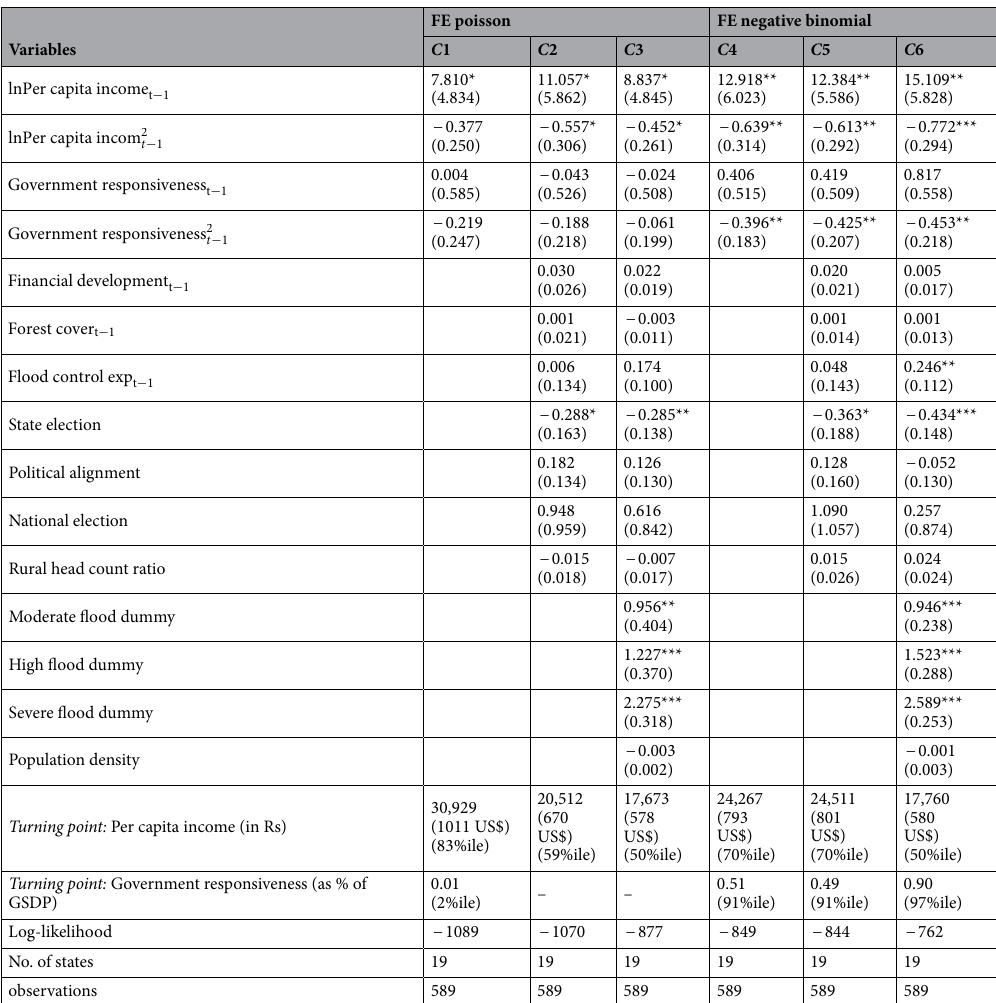
Table 2. Population affected, per capita income (PCI) and Government responsiveness (All States). Clustered standard errors at state-level are reported in parentheses. The level of significance at *** p < 0.01, ** p < 0.05, * p < 0.1. The dependent variable is the population affected by floods. Time-invariant state and year fixed effects are included in all models. The low flood is the baseline dummy variable.